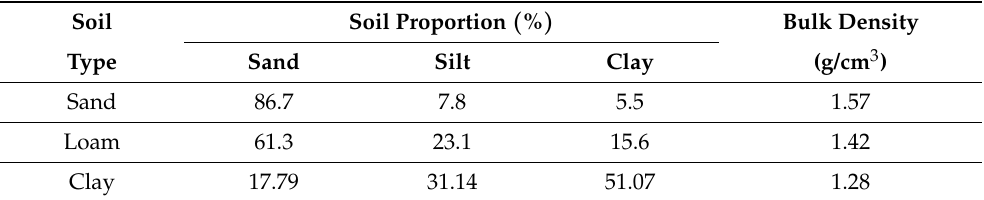
Table 1. The composition of different soil samples used in this study. Soil Soil Proportion ( % ) Bulk Density Type Sand Silt Clay (g/cm 3